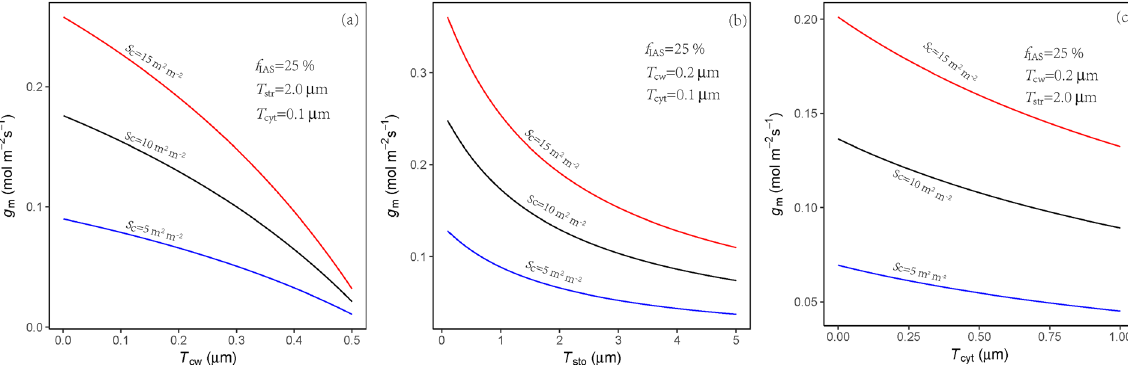
Figure 6. Modelled mesophyll conductance at 25 °C response to cell wall thickness ( T cw ), chloroplast stroma thickness ( T str ) and cytoplasm thickness ( T cyt ). Membrane conductance was the same in all simulations. f ias , volume fraction of intercellular air space and S c , area of chloroplast surface exposed to intercellular